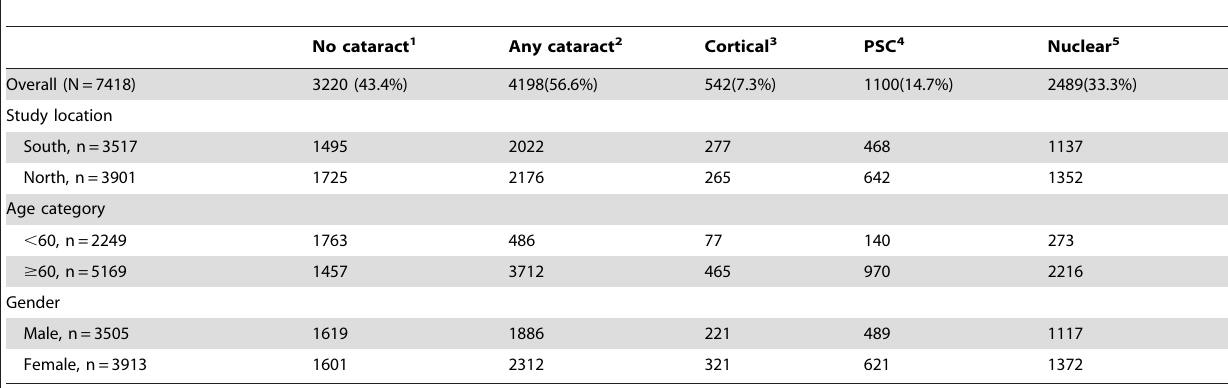
Table 1. Distribution of participants by cataract status for those who have at least one of the genotyped SNPs.